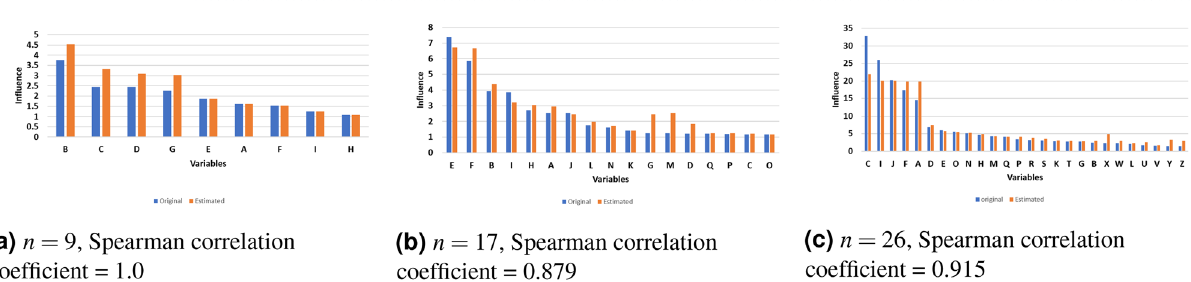
Figure 4. Pairwise comparisons between the true causal influences of individual nodes in three random synthetic networks with that of causal influences of the same nodes in inferred causal networks. The values are shown as paired bar charts ordered by decreasing true influence values. The ordering of the inferred influence for the top ten most influential variables is consistent with the true values.